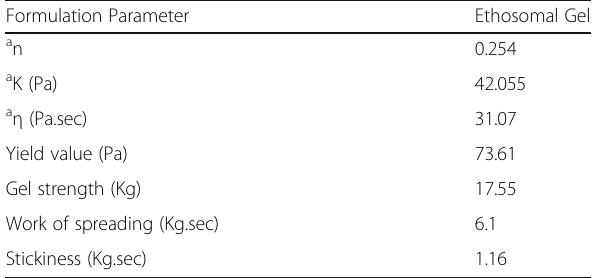
Table 2 Rheological characteristics of the developed Ethosomal Gel formulation Formulation